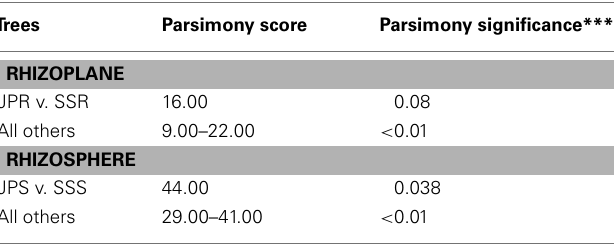
Table 1 | Results from parsimony tests (mothur) of neighbor-joining trees containing diazotroph sequences recovered from band stabs of or rhizosphere (sediments) of different plant